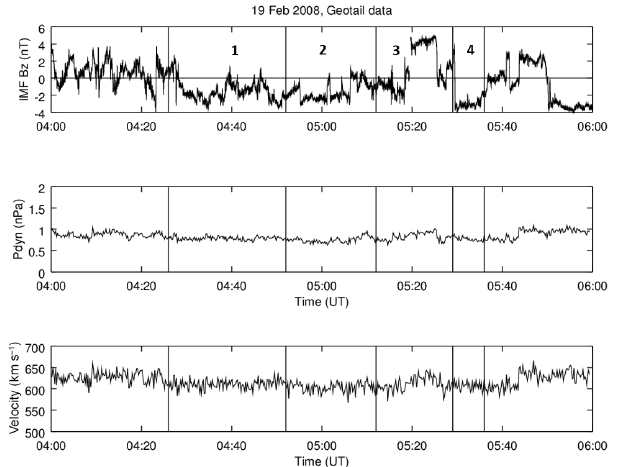
Figure 10. Geotail measurements of IMF Bz (top, GSM coordi- nates), dynamic pressure (middle), and density (bottom). The peri- ods 1–4 from Fig. 5 are marked here with the black vertical lines and numbers with the assumption that the propagation time from the magnetopause to ionosphere is 14min.